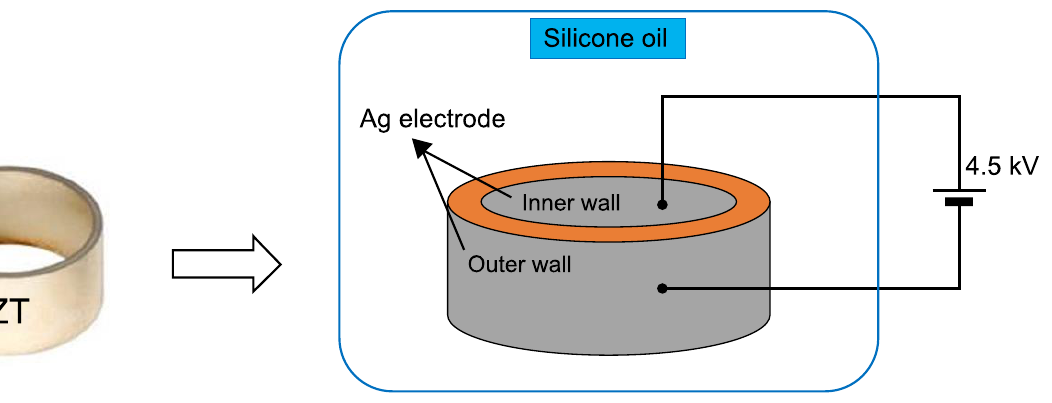
Figure 1. Poling process for ring-shaped PZT ceramic.